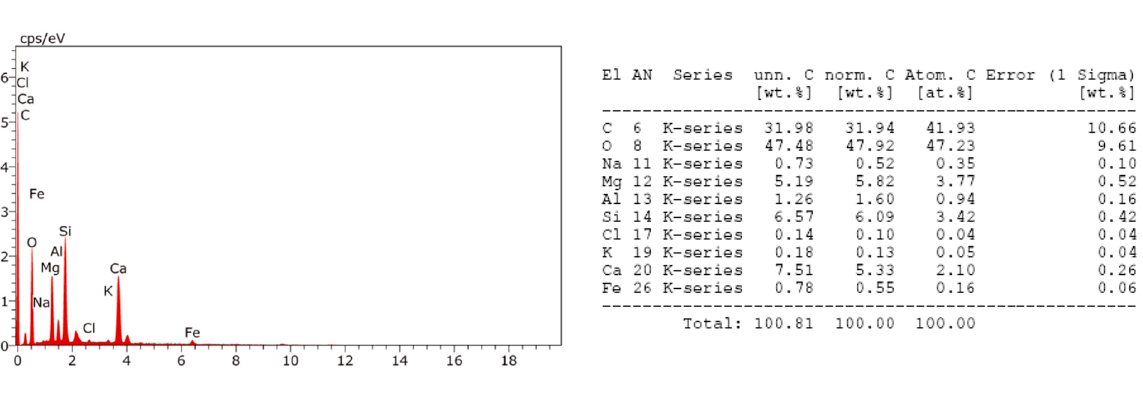
Figure 10. EDX analysis of TBM muck Sample #3.